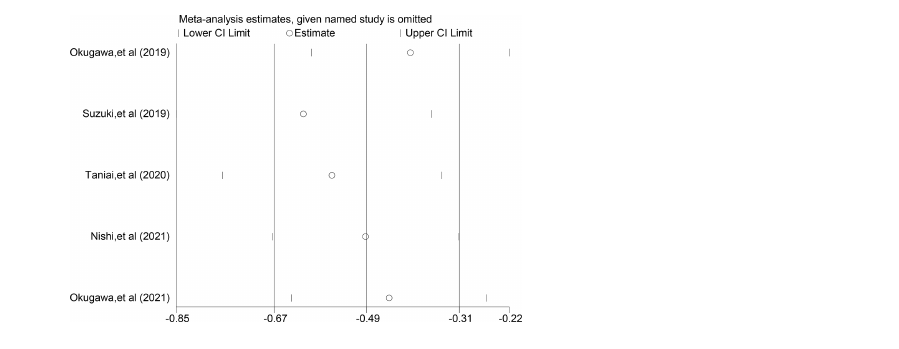
FIGURE 5 | Sensitivity analysis of relationship between LCR and